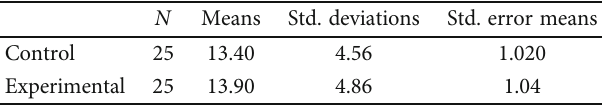
Table 2: Descriptive statistics of the two groups in the speaking